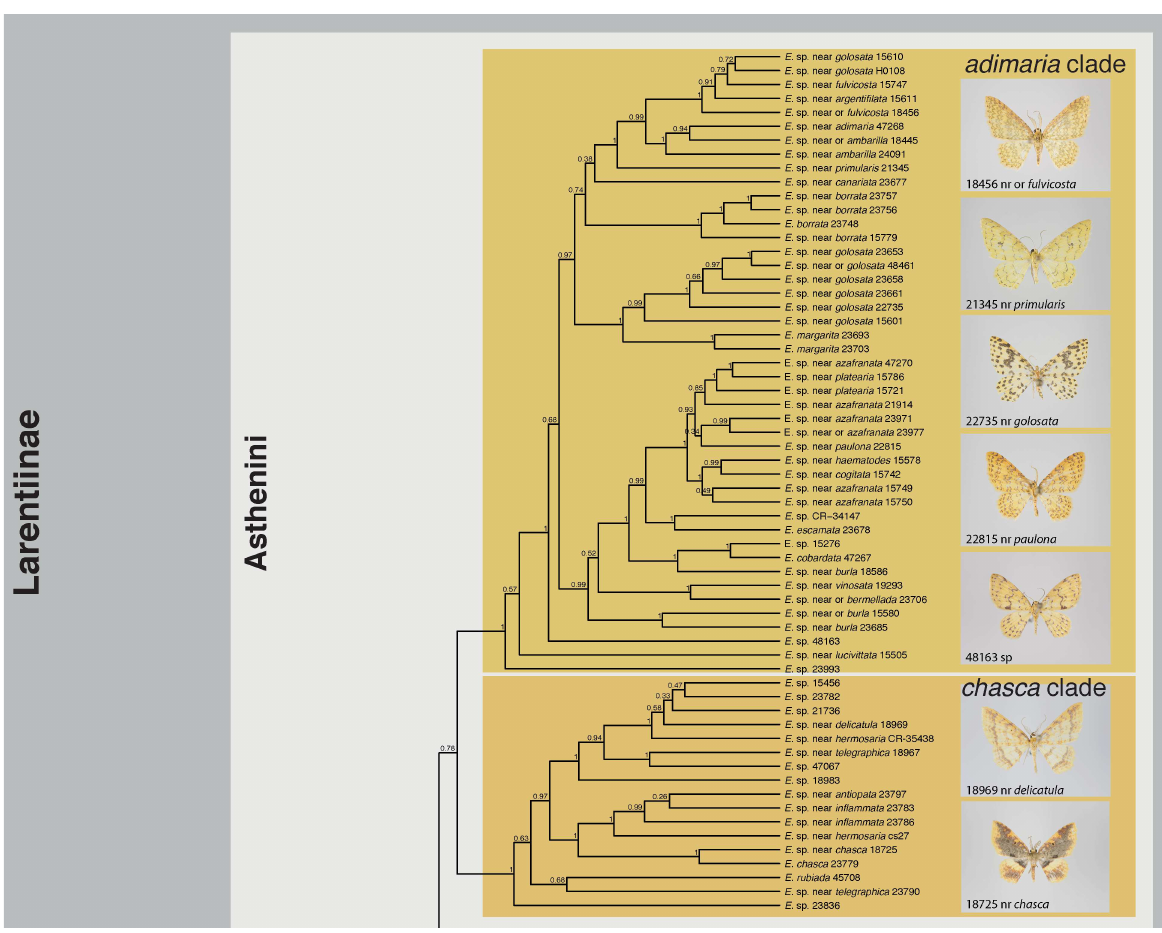
Fig 4. Phylogenetic tree obtained from BEAST, Part 4. All informally named infrageneric clades are indicated along with photographs of select members of each clade within Neotropical Eois . Bayesian posterior probabilities are given at nodes.